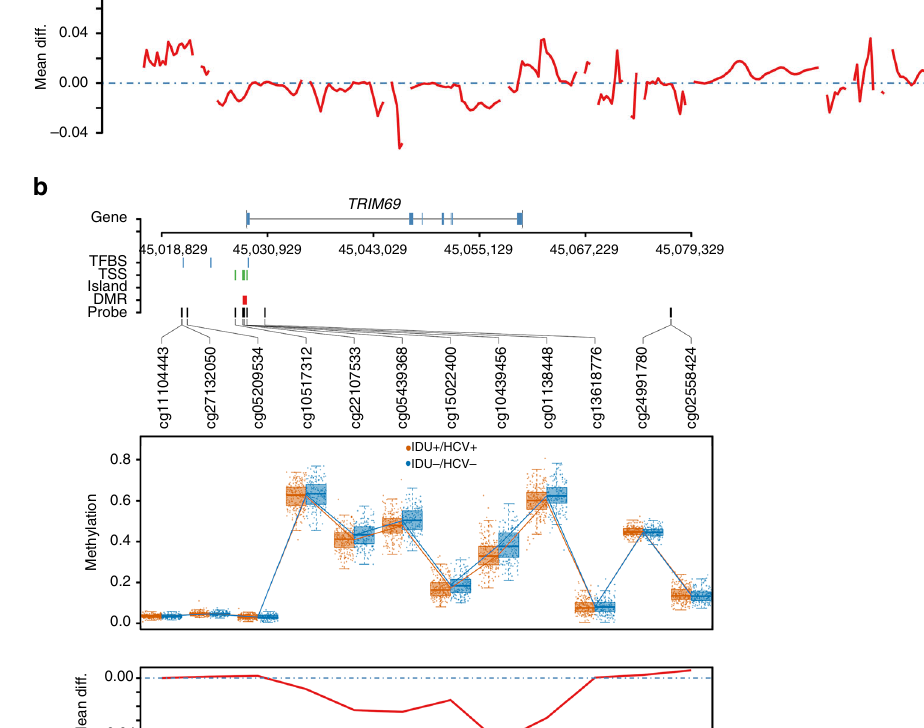
Fig. 2 Differential DNA methylation regions between injection drug use with hepatitis C and non-injection drug use without hepatitis C in HIV-infected individuals. a Differential methylation region on chromosome 6q21 that hosts MHC class I and II: Top panel: from top to bottom, the panel shows gene location, transcription factor binding sites (TFBS), probes located within 1500 or 200 bp from transcription start site (TSS), probes in CpG islands (Island), differential methylation region (DMR), genomic location of each probe. Middle panel: methylation ( β ) in injection drug use with HCV (IDU+/HCV+) and non-injection drug use without HCV infection (IDU − /HCV − ). Bottom panel: average methylation differences between IDU+/HCV+ and IDU − /HCV − . The results are from the discovery samples. b Differential methylation region (DMR) on the promoter of TRIM69 in the discovery sample. Top panel: genomic location of each probe, transcription binding site, DMR; middle panel: methylation at each probe in injection drug use with HCV (IDU+/HCV+) and non- injection drug use without HCV (IDU − /HCV − ); bottom panel: average methylation difference between IDU+/HCV+ and IDU − /HCV